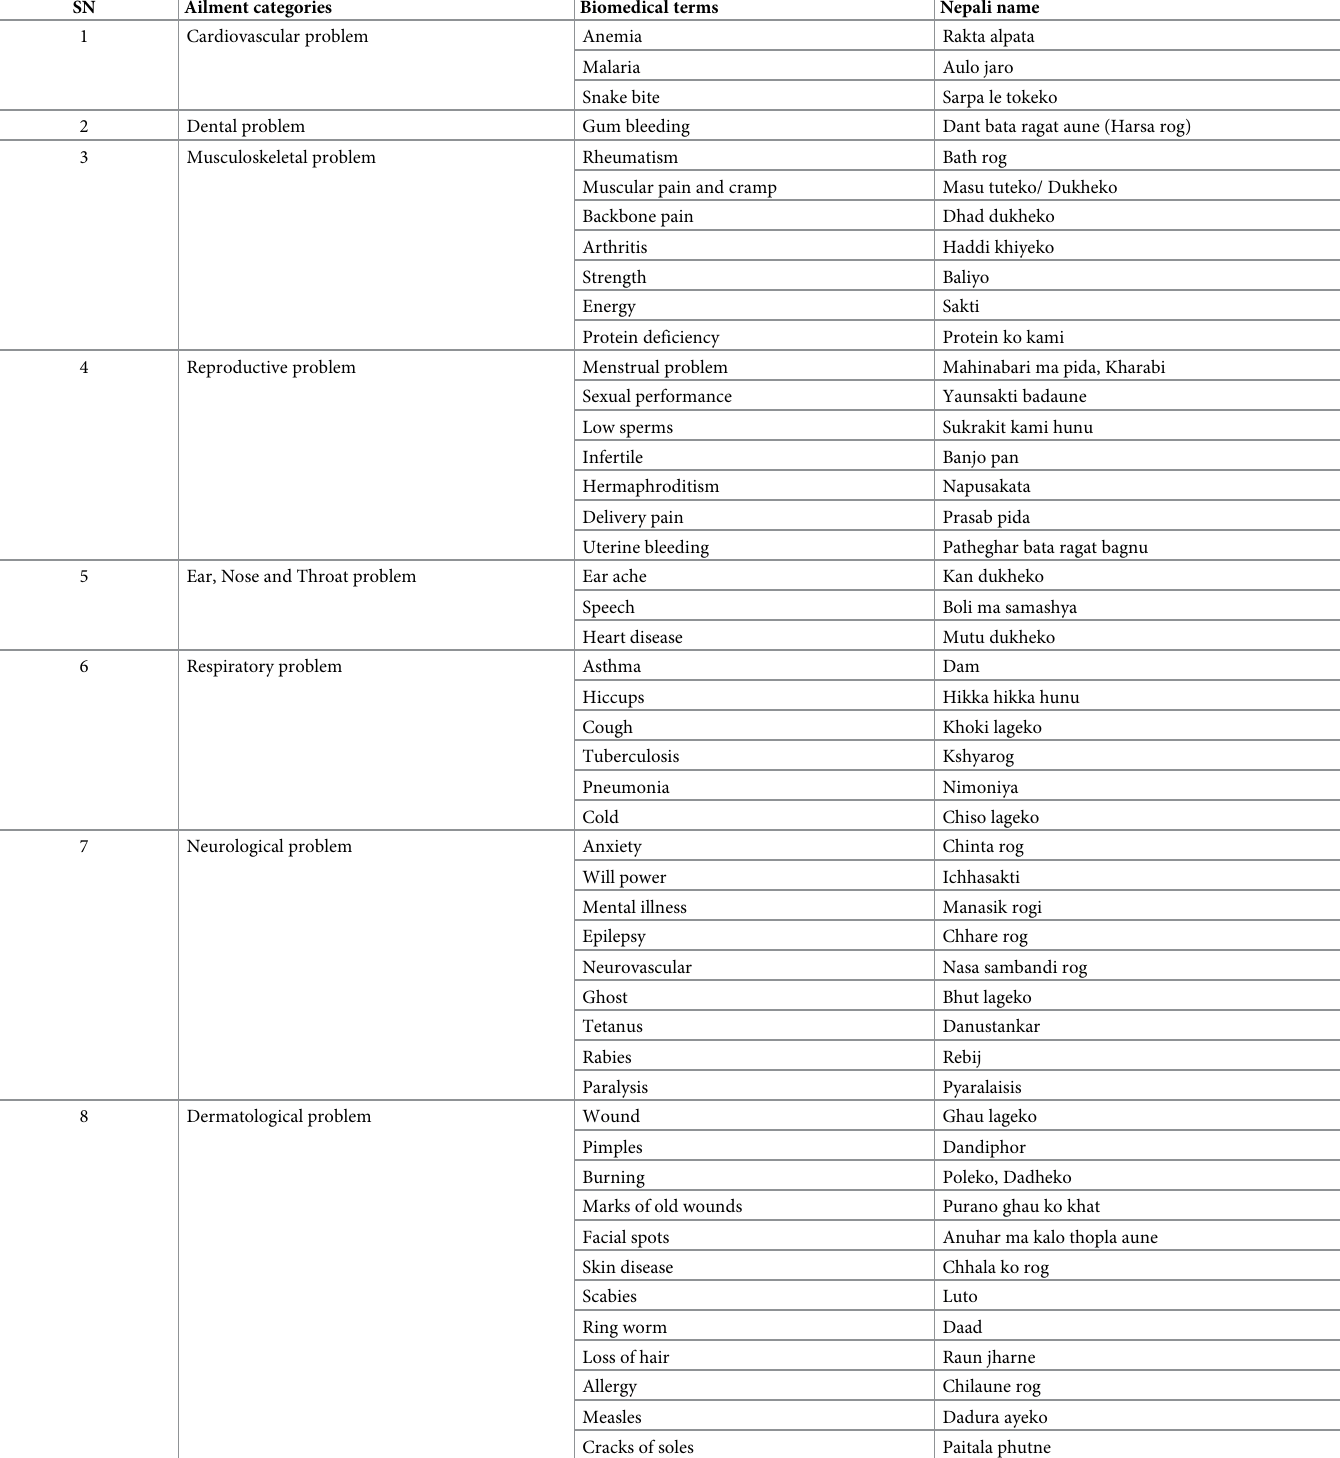
Table 1. List of ailments grouped into different